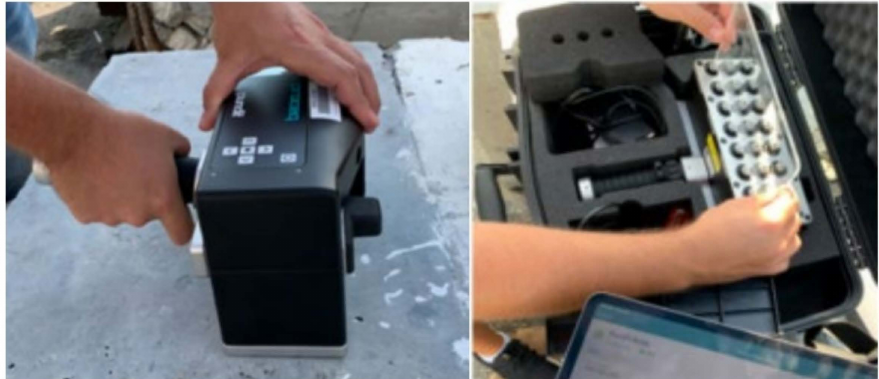
Figure 11. Phased-array ultrasonic technology (PAUT).